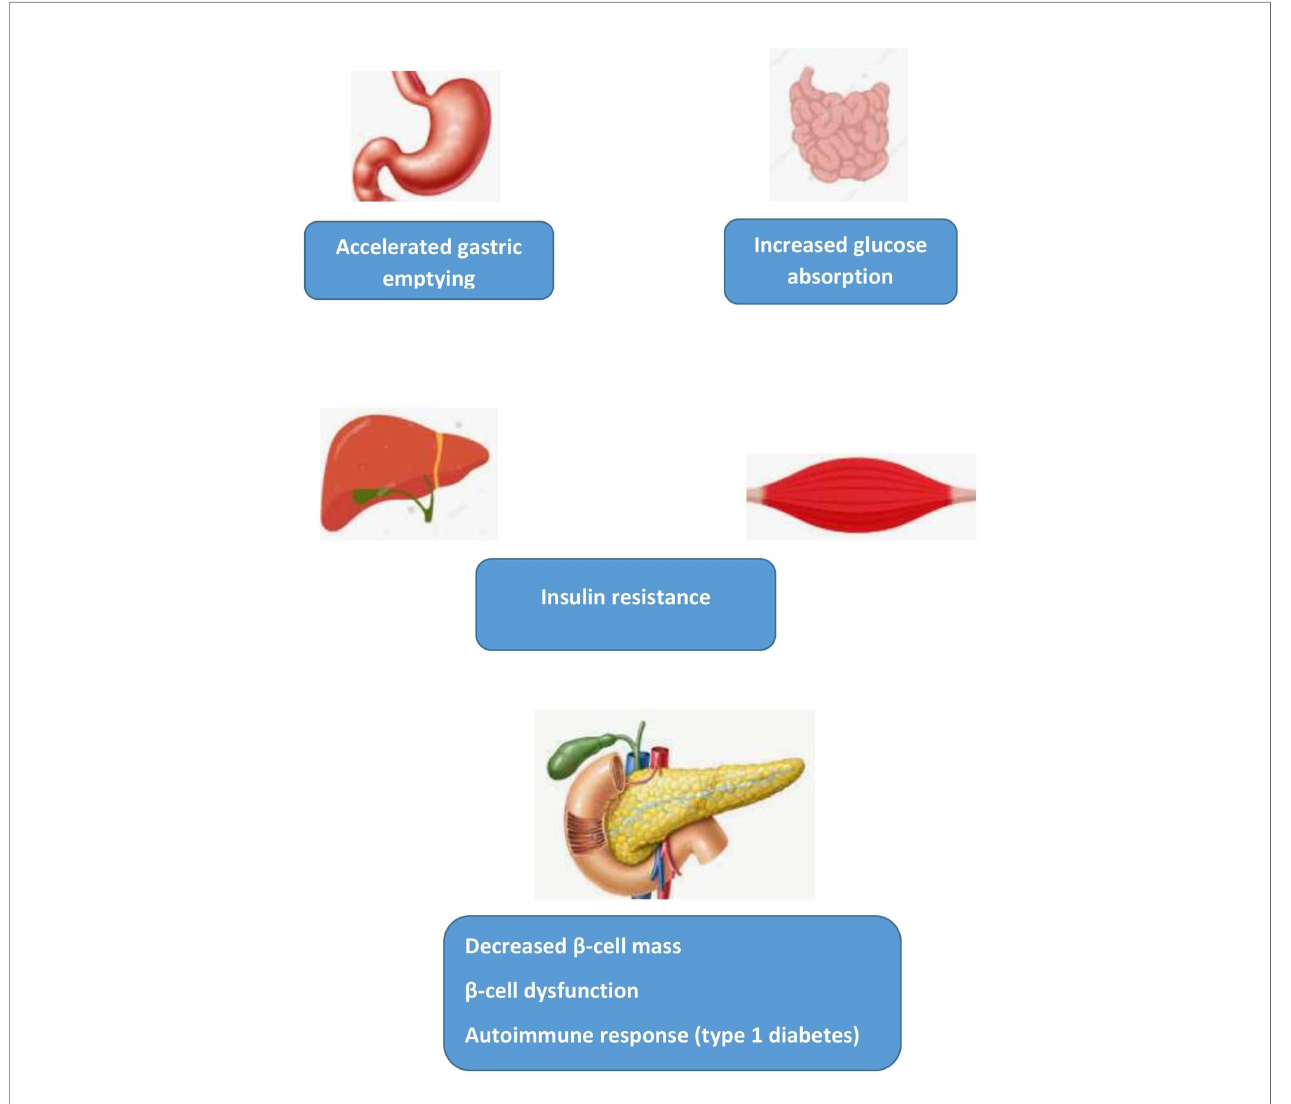
FIGURE 1 | Elevated 1-hour plasma glucose: “ common soil ” pathophysiological mechanisms. Adapted from Fiorentino et al.